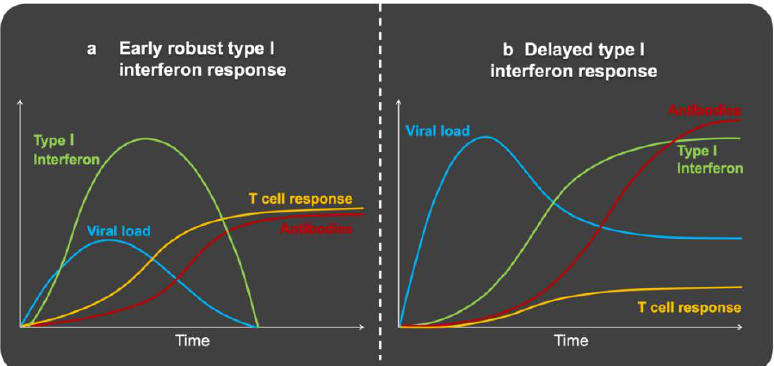
Figure 2. Schematic representation of immune response leading to ( a ) mild COVID-19 and ( b ) severe COVID-19. ( a ) Mild COVID-19 produces an early and robust type I interferon response. This limits the multiplication of the virus and its spreading. There is an adequate T-cell response and antibody formation. This type of response is characteristic of young people and also occurs when they are exposed to a low amount of virus. ( b ) In severe COVID-19, the type I interferon response is delayed. This gives the virus the chance to multiply and spread quickly. There is also an inadequate T cell response with low T cell numbers. Patients with severe COVID-19 achieve higher peak antibody titers and at a later time. This type of response is characteristic of the elderly and persons with metaflammation in general. It also occurs when they are exposed to a high viral load. Adapted by permission from Springer Nature: Nature Reviews Immunology (The First 12 Months of COVID-19: A Timeline of Immunological Insights, Carvalho, T.; Krammer, F.; Iwasaki, A., 2021) [132], available at https://www.nature.com/articles/s41577-021-00522-1 (License Number: 5254880681651, accessed on 23 February